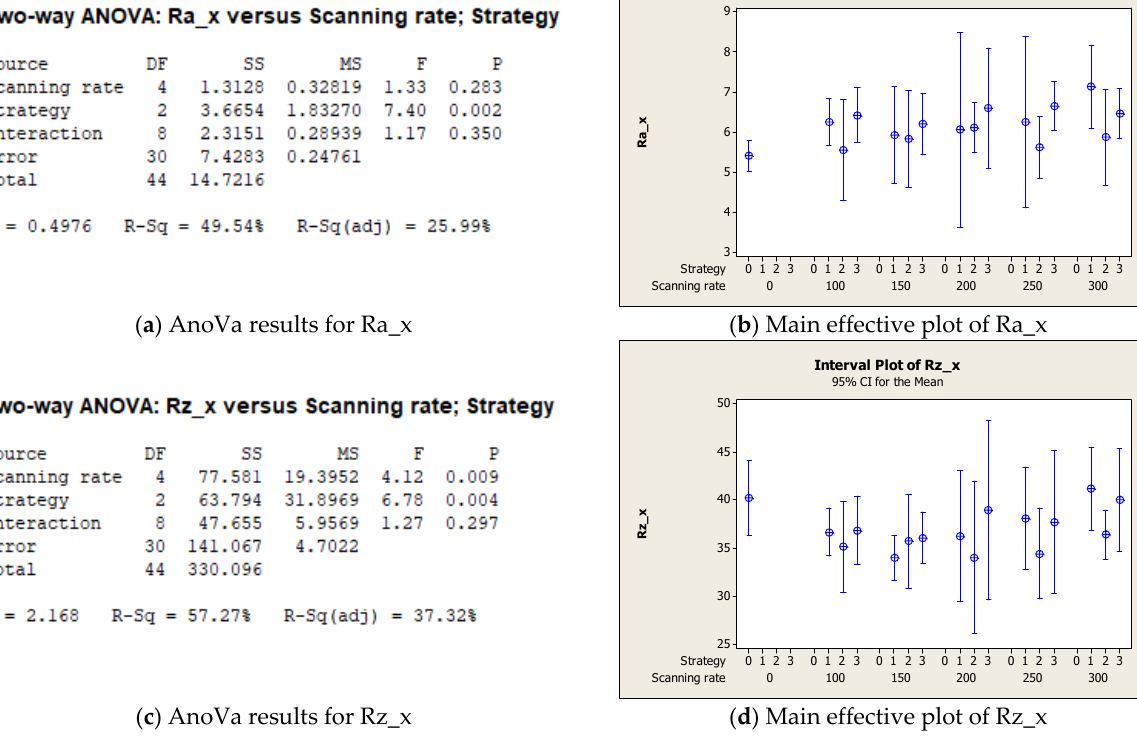
Figure 5. Main results of statistical analysis along the x direction. ( a ) AnoVa results for Ra_x; ( b ) Main effective plot of Ra_x; ( c ) AnoVa results for Rz_x; ( d ) Main effective plot of Rz_x.